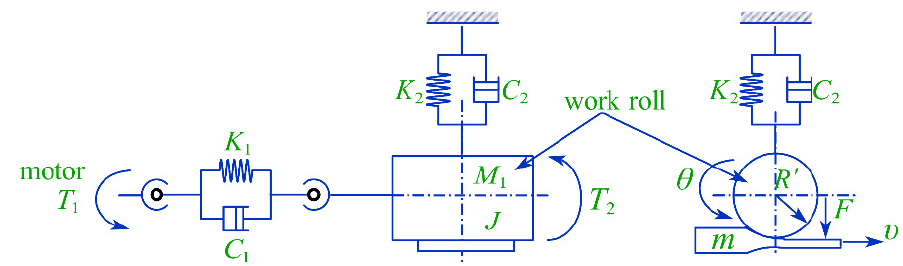
Figure 3. F3 frame model .